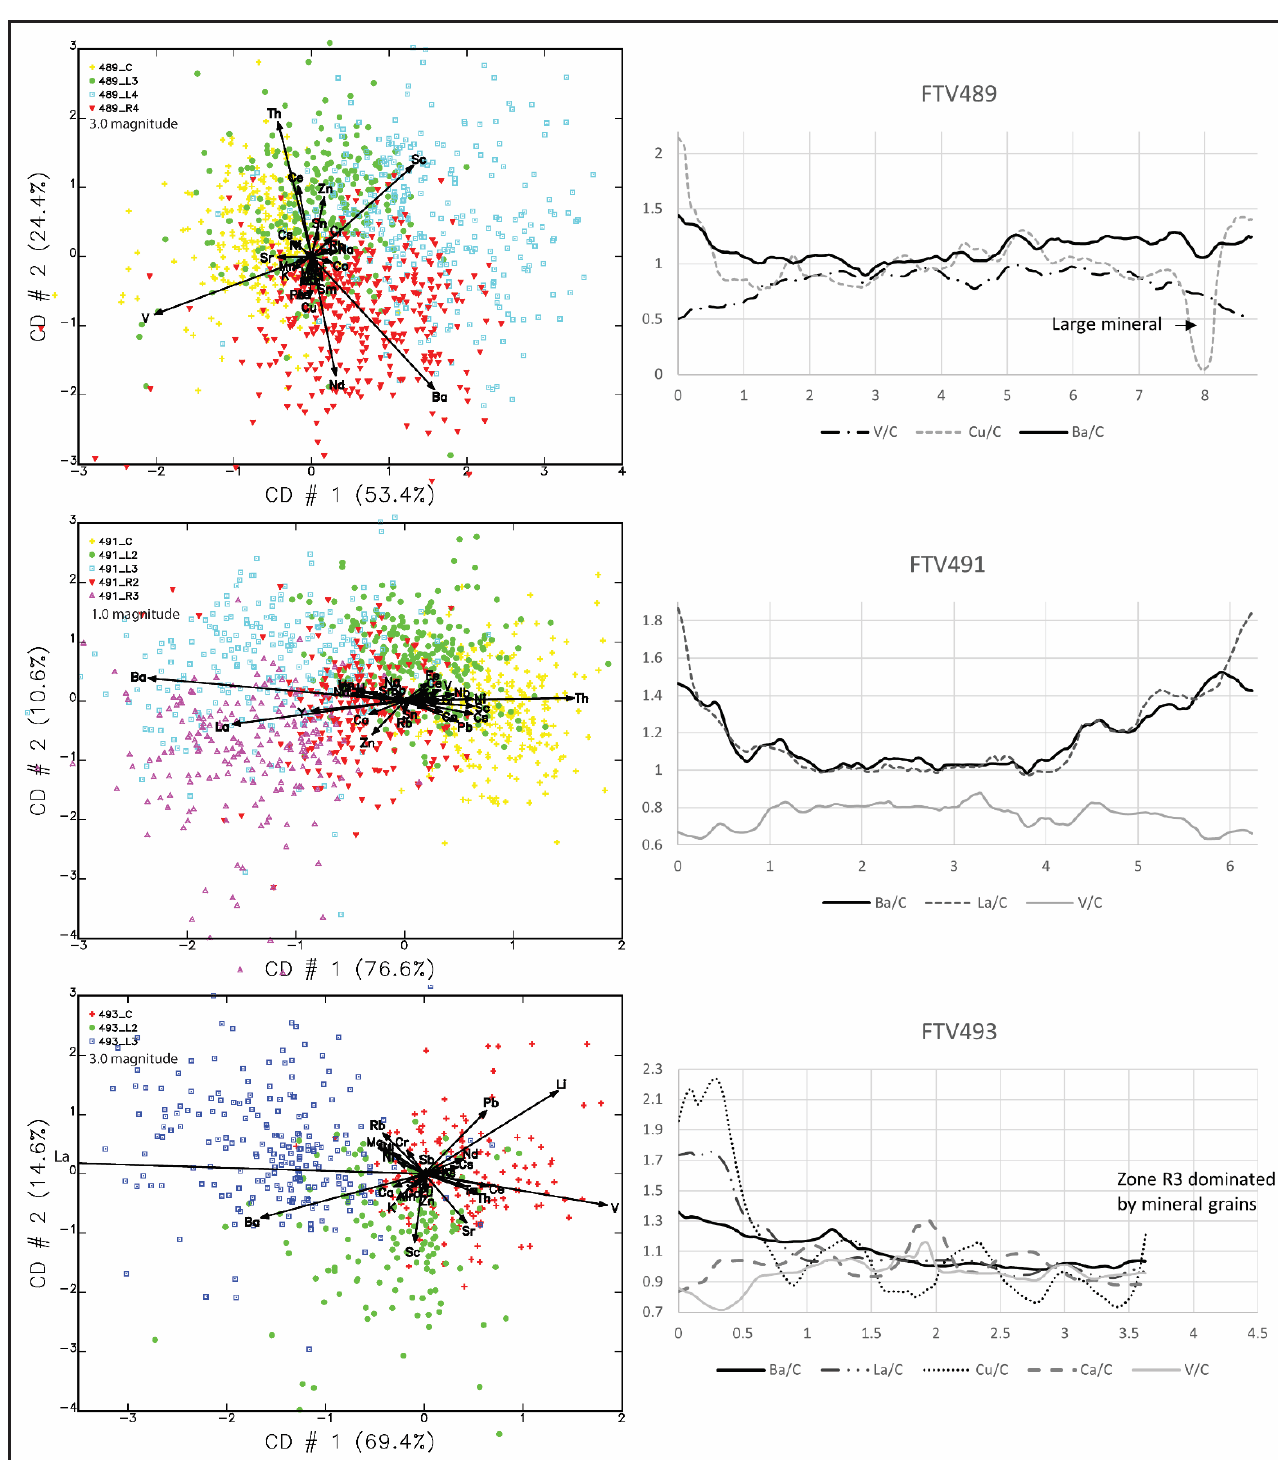
Figure 11. Samples FTV489, FTV491, and FTV493. ( Left ) Canonical discriminant analysis of trimmed data points coded by zone (zones that do not diverge from the core not shown). ( Right ) Profiles of trimmed and smoothed data for elements that show significant zonal patterning. The x-axis is the position in the cross-section of the sherd in millimeters; the y-axis is the concentration of elements (in μg/g) expressed as a ratio to the average core concentration for the same element. Other elements that show enrichment at the surfaces include those that tend to covary in nature, including the elemental pairs of copper and zinc, lead and tin, and arse- nic and antimony (see Figures 9 and 10). Other surface-enriched elements include lithium, lanthanum (and some other rare earth elements), and sometimes calcium and strontium.